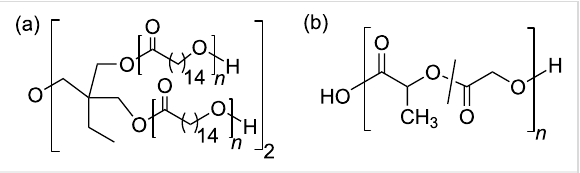
Figure 8: Structural description of (a) PPDL-D4 and(b)